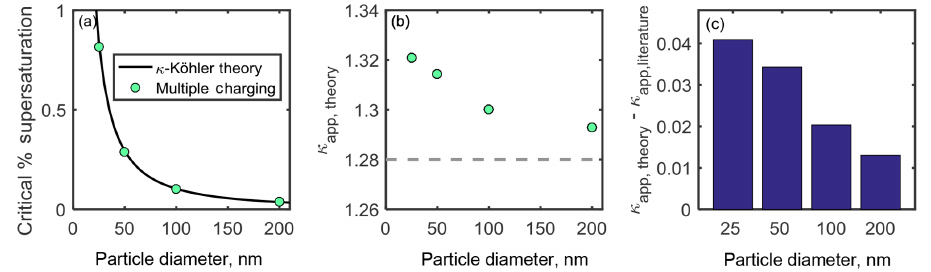
Figure 6. (a) Critical percent supersaturation of sodium chloride particles determined from activated fraction curves shown in Fig. 5. A κ -Köhler curve for sodium chloride is shown for comparison. (b) Theoretical κ app for each particle diameter (gray dashed line indicates literature value for κ NaCl app ). (c) Artifacts in κ app resulting from multiple particle